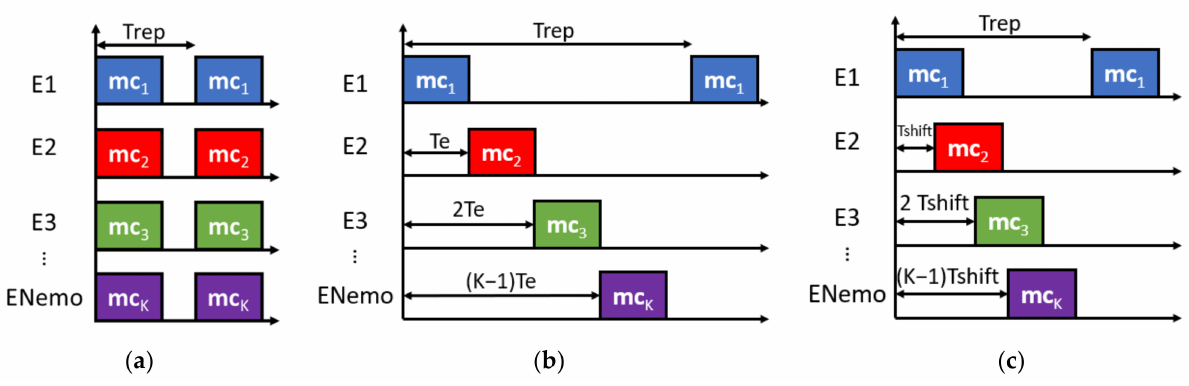
Figure 6. Configuration of the multiple emission scheme: ( a ) CDMA, ( b ) TCDMA ( T shift = T e ), and ( c ) TCDMA with configurable T shift